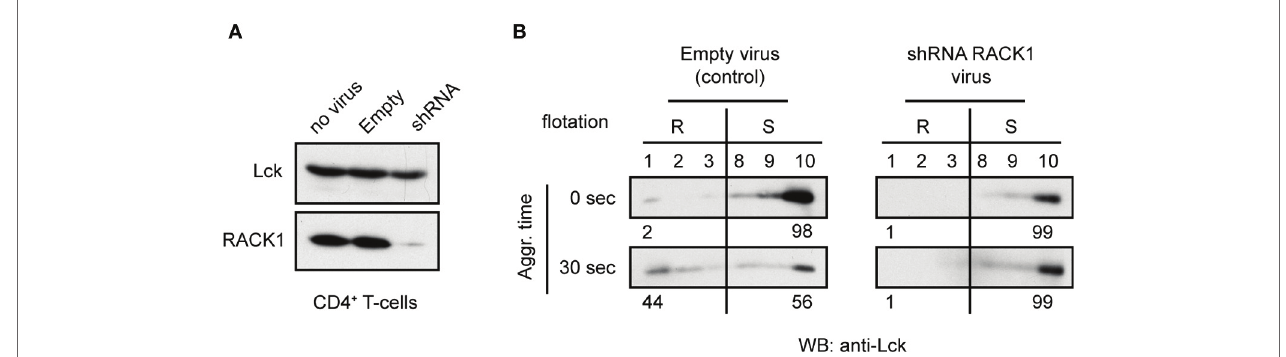
FigUre 8 | adenovirus mediated knockdown of racK1 impedes translocation of lck to light DrMs . CD4 + T-cells from TgCAR transgenic mice were infected with either empty control virus (Empty) or with a mixture of adenoviral RACK1-targeting shRNA constructs (shRNA) or were not infected (no virus). (a) The effectiveness of RACK1 downregulation is shown 96 h after infection. Cells were harvested and probed with anti-Lck and anti-RACK1. (B) CD4 + T-cells infected with Empty virus (control) or shRNAs RACK1 virus were activated by TCR/CD4 co-aggregation (30 s), or not (0 s), and the redistribution of Lck to light DRMs was assessed. Raft (#1–3, R) and soluble (#8–10, S) fractions were probed with anti-Lck. Numbers represent relative distribution of Lck to these fractions. Blots are representative of two independent